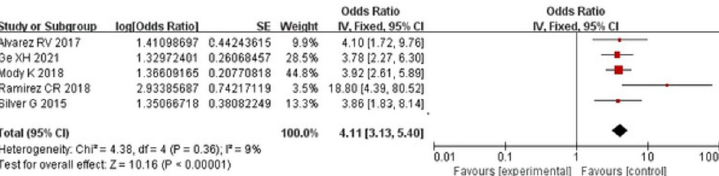
Fig 3. Forest plot for mechanical ventilation analysis. We conducted meta-analysis for 5 studies using a random effect model. We used ORs and 95% CIs to represent the results.